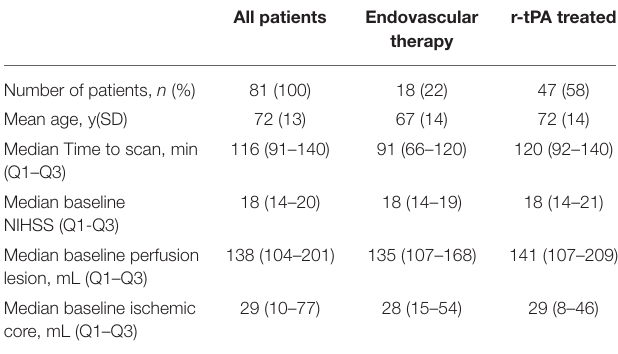
TABLE 1 | Patient clinical and imaging characteristics grouped by treatment received. All